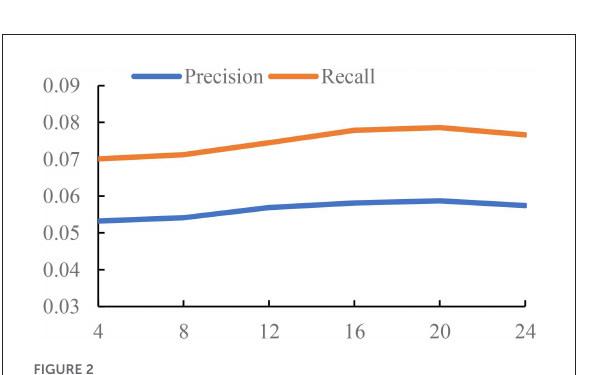
FIGURE2 The impact of time threshold on Foursquare.